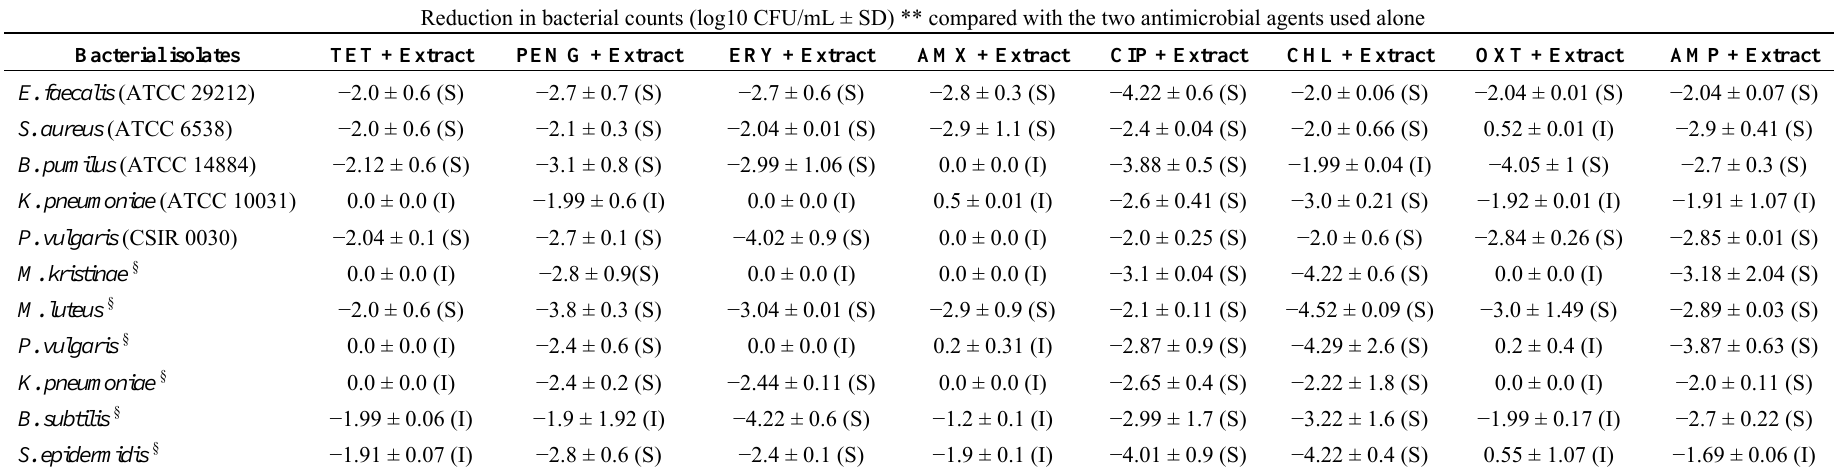
Table 3. In vitro activity of Extract-Antibiotic combination at MIC level against test bacterial isolates.